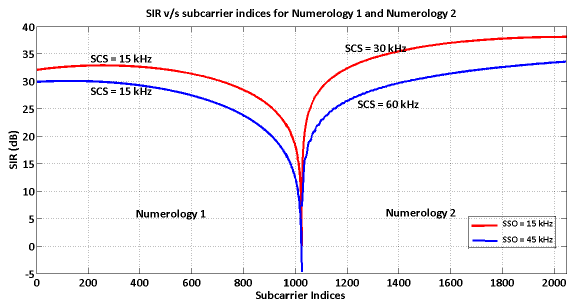
Fig. 3. SIR performance with SSO 15 kHz and 45 kHz